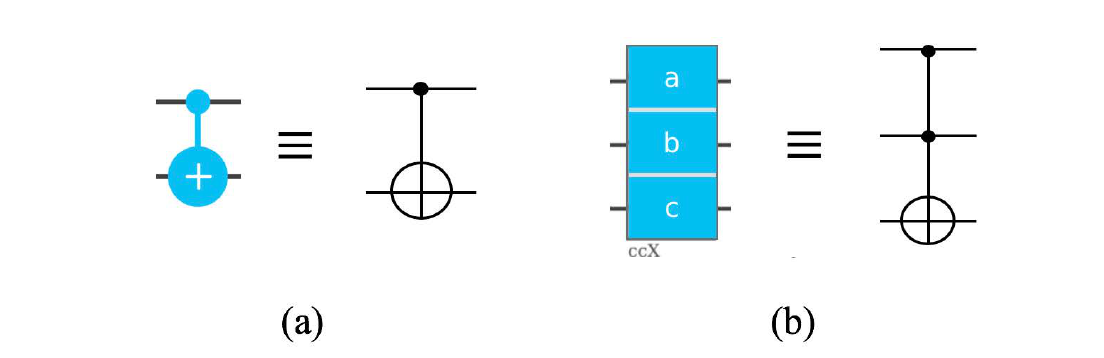
Figure 5. Quantum operators in the quantum scores of IBM QE. ( a ) The CNOT gate. The little dot denotes the control qubit and the larger circle with a “+” denotes the target qubit. ( b ) The “ccX” subroutine, which is actually the Toffoli gate. Letters in the blue blocks denote the different qubits in the multi-qubit operation, like the a and b are the control qubits and the qubit c is the target